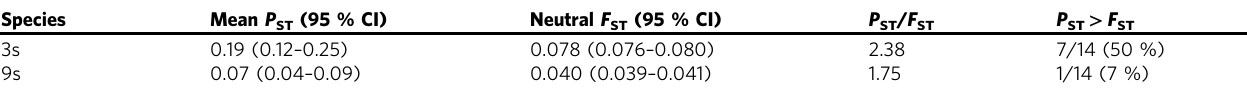
Table 2 Phenotypic (P ST ) and neutral genetic (F ST ) differentiation in the three-spined stickleback (3s) and in the nine-spined stickleback (9s) Species